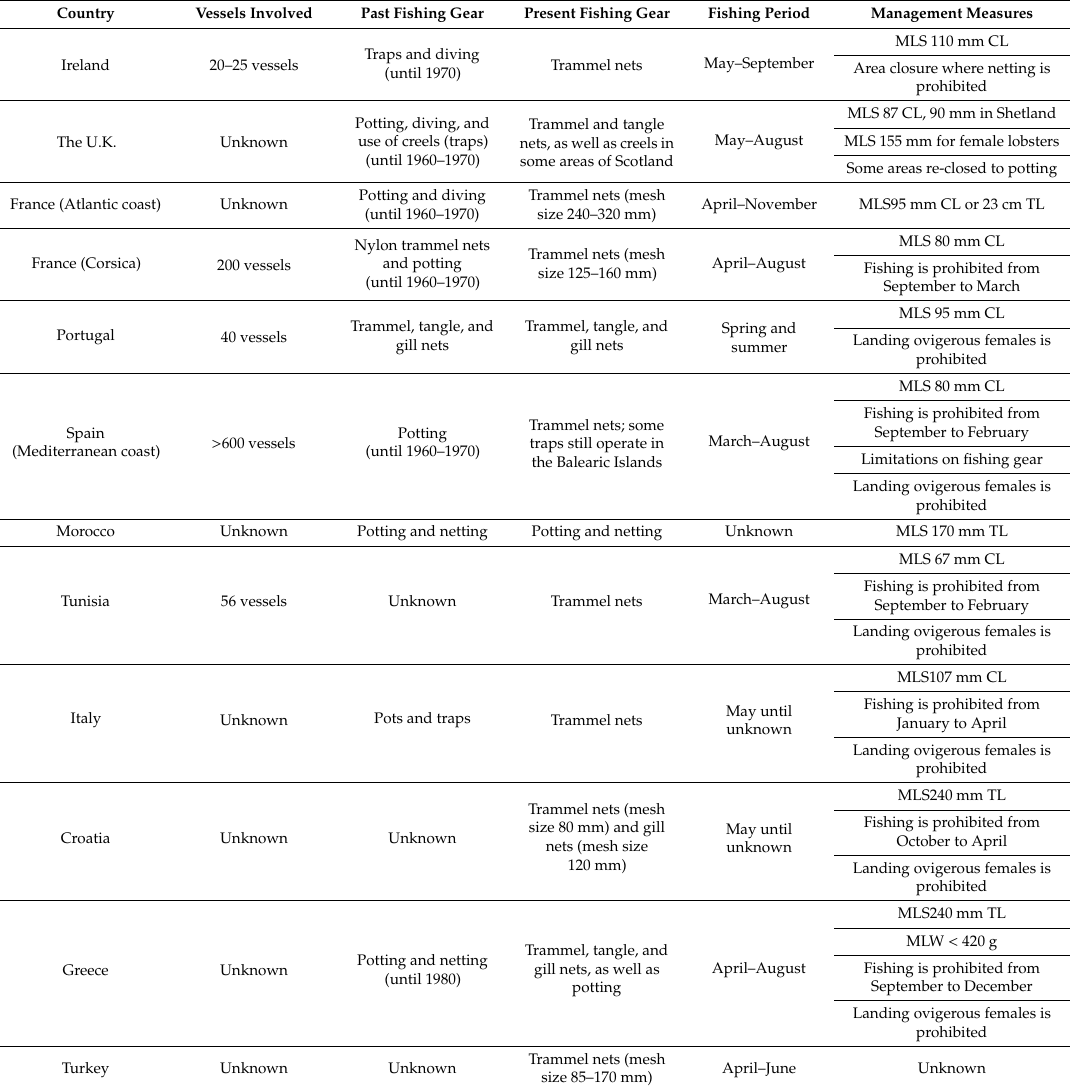
Area closure where netting is prohibited